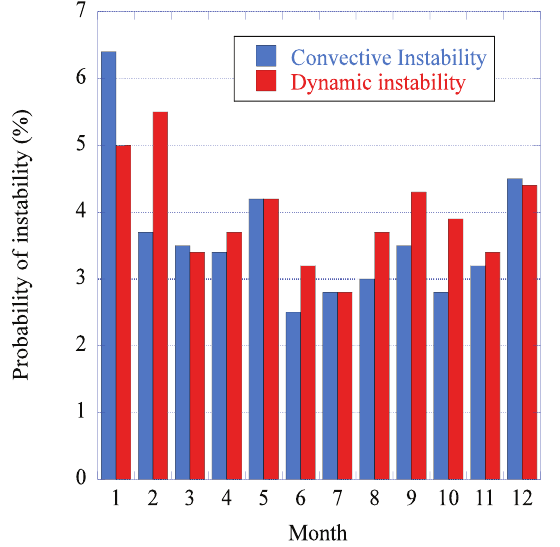
Fig. 4. Monthly mean probability of convective and dynamic insta- bility at 83–91km.